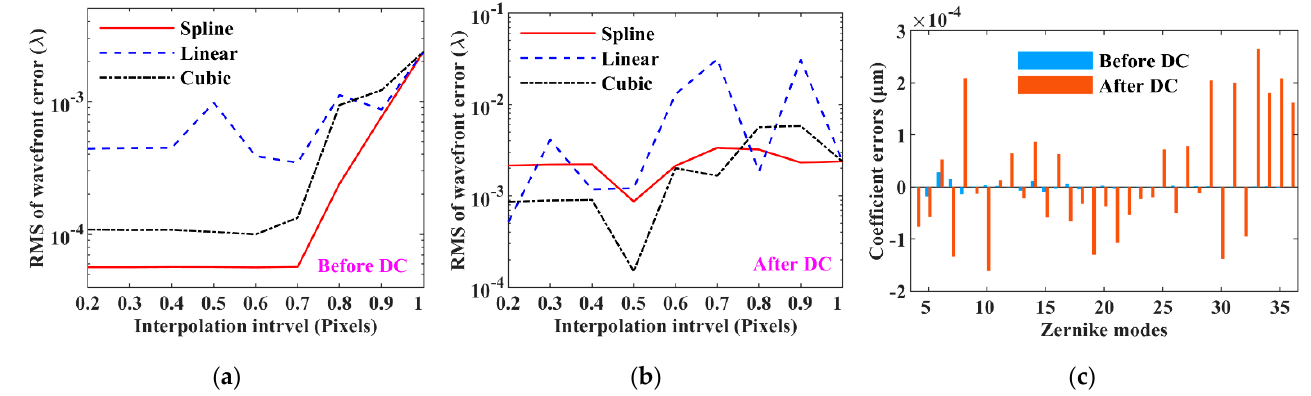
Figure 5. Effect of data interpolation on the performance of vSHWS. RMS varying with interpolation interval when performing interpolation ( a ) before and ( b ) after the DC; ( c ) comparisons of Zernike coefficient errors obtained before and after the DC.